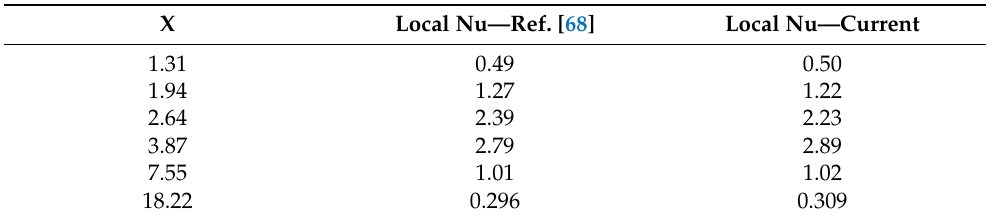
Figure 2. MIT results at two Rew ( a ) and mesh distribution ( b ) (Re = 500, Da = 0.1, sc = 5Rc). Table 3. Code validation 1: Local Nusselt numbers for slot J-I HT considering different locations along a hot surface, (Re = 100).